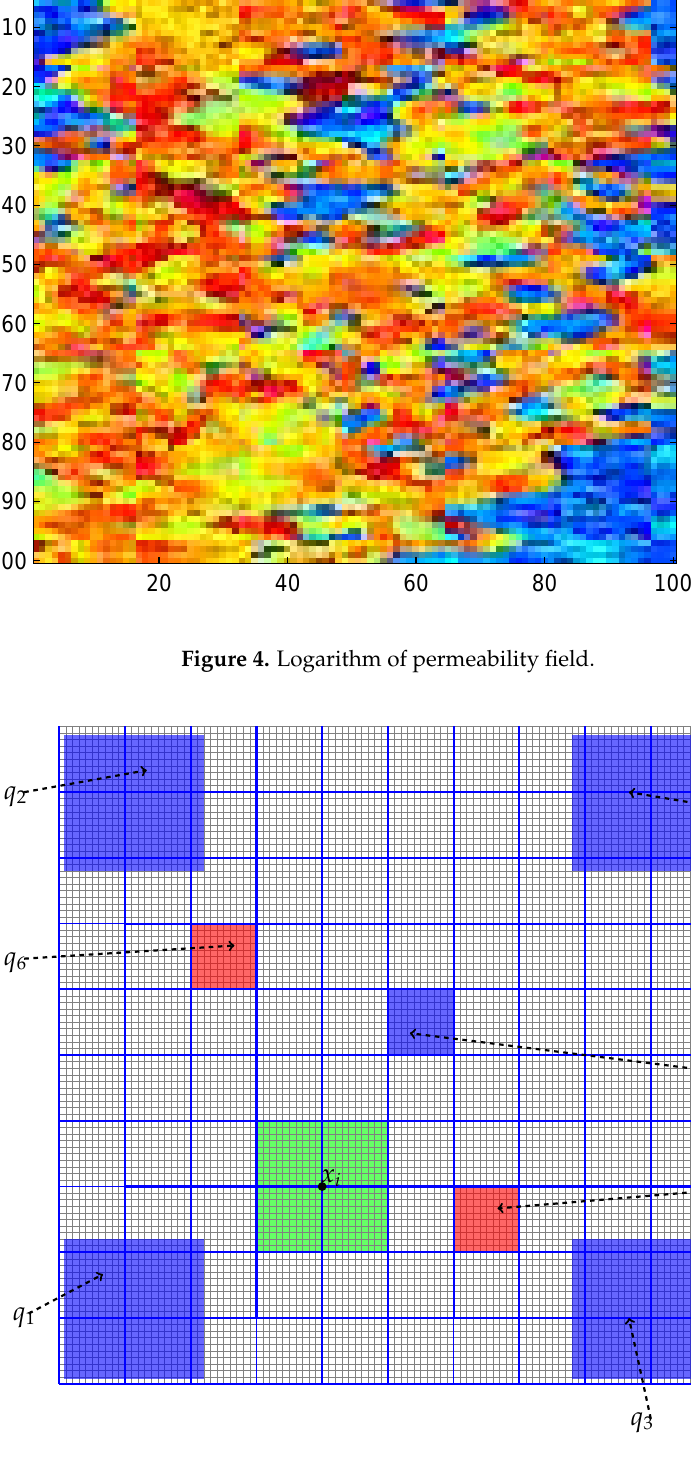
Figure 5. Grid information and q .